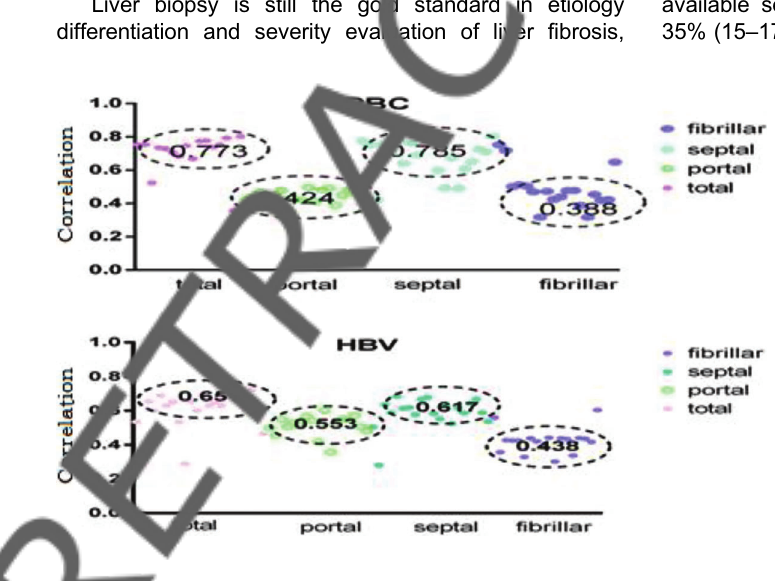
Figure 3. Correlation of parameters and stages of liver fi brosis in samples from chronic hepatitis B (CHB) and primary biliary cirrhosis